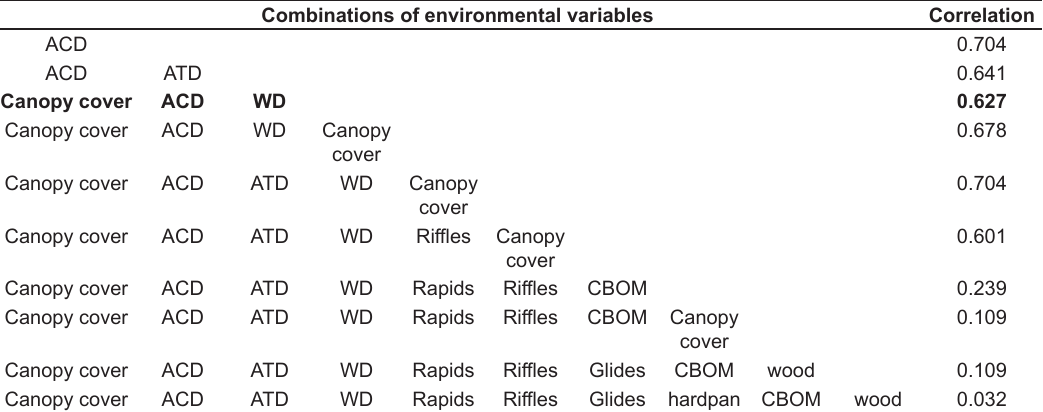
Table 3. BIOENV result for the correlation between the ten environmental predictors and the communities of Cladocera. In bold the selected